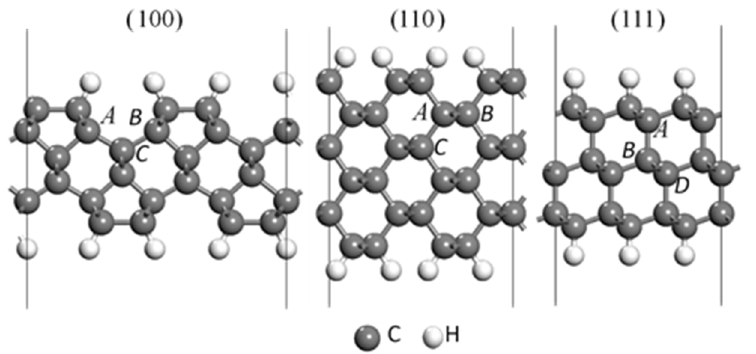
Figure 2. (Color online) Supercell structures used for diamond (100) surface, diamond (110) surface, and diamond (111) surfaces. Each surface contains 24 hydrogen atoms and 72 carbon atoms. The letters A , B , C , and D denote positions of nitrogen atoms. White and gray spheres represent H and C atoms,